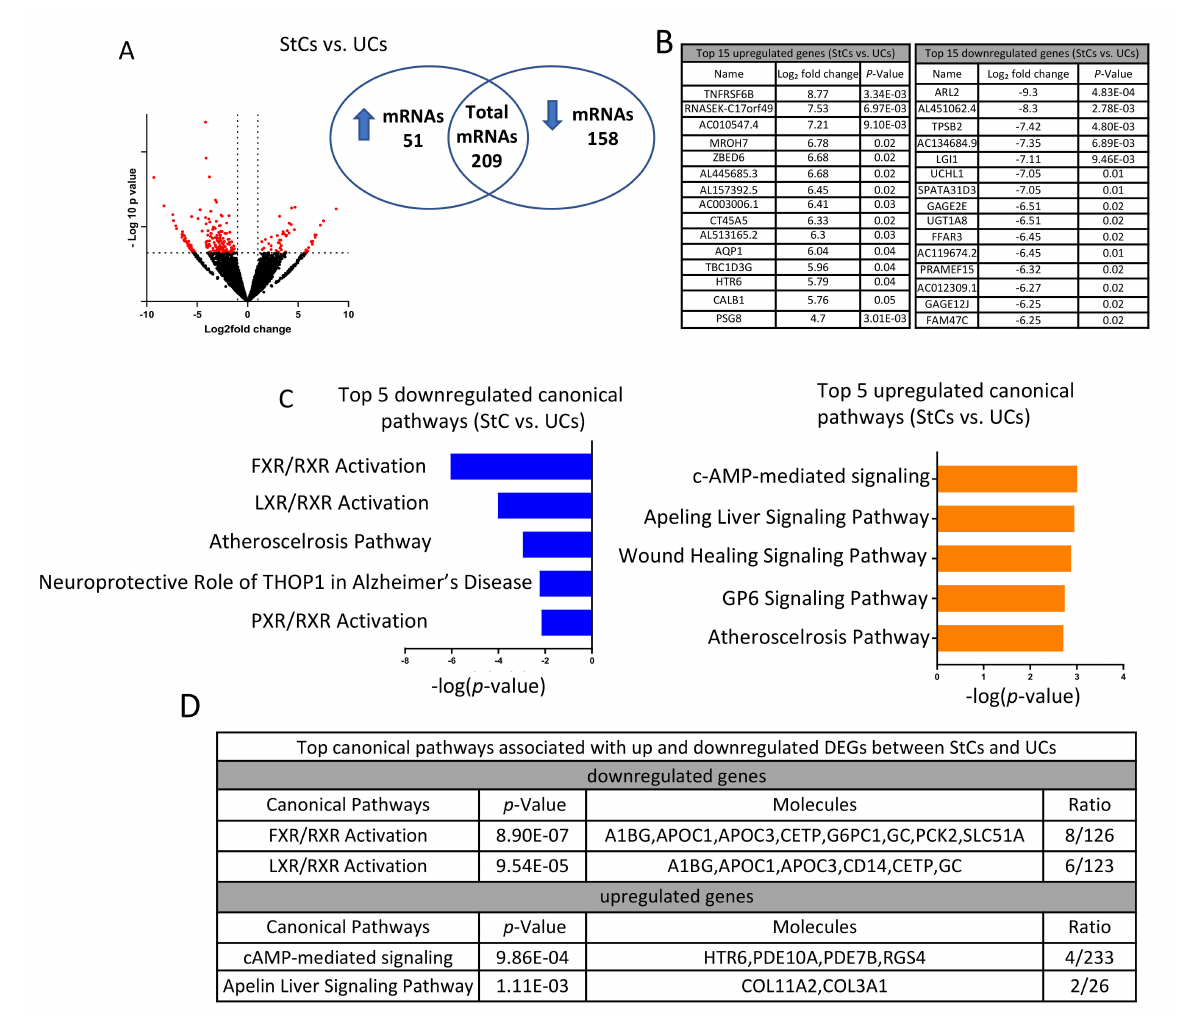
Figure 2. Transcriptome analysis of steatotic versus untreated cells. ( A ) Volcano plot showing that 209 mRNAs were statistically differentially regulated (black dots; ≥ 2-fold difference, adjusted p < 0.05), of which 51 were significantly upregulated and 158 significantly downregulated. ( B ) Top 15 individual up- and downregulated transcripts between StCs and UCs. ( C ) Top five up- and downregulated canonical pathways identified by IPA. ( D ) Top two canonical pathways identified by IPA using up- or downregulated genes and the number of molecules involved. The ratio indicates the number of genes in the analyzed data over the number of genes known to be involved in the